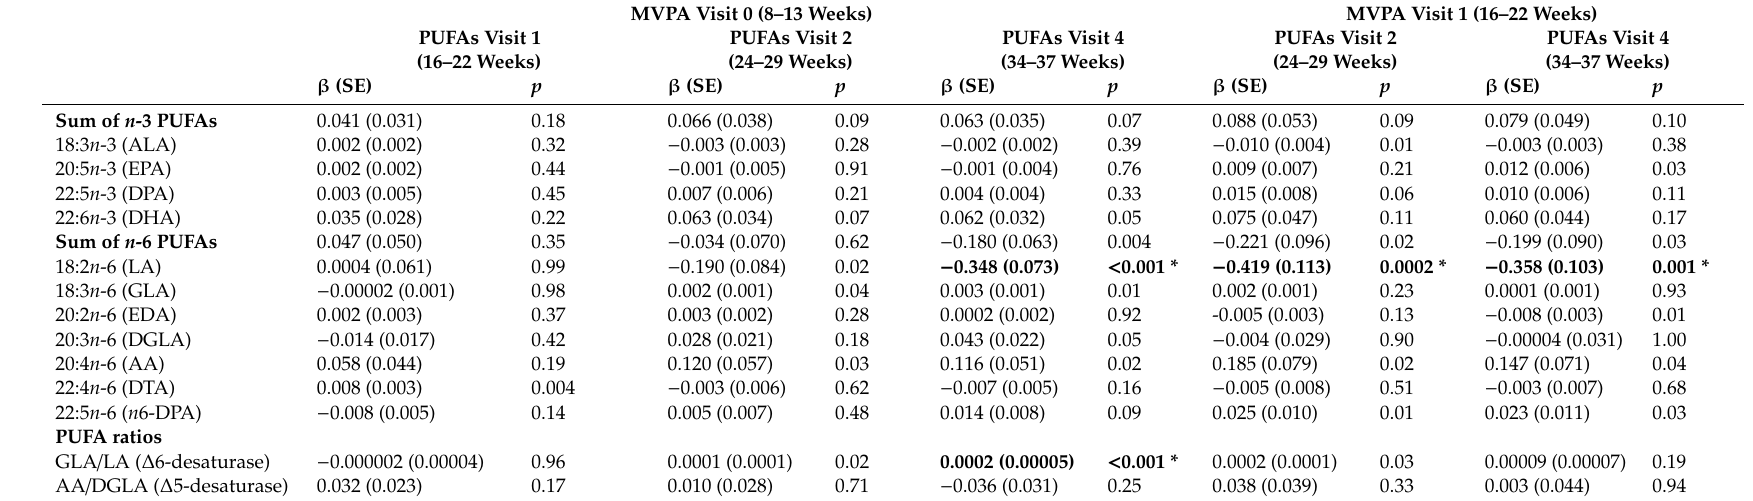
Table 3. Prospective associations of maternal moderate-to-vigorous physical activity (MVPA) and plasma phospholipid polyunsaturated fatty acids (PUFAs) in the NICHD Fetal Growth Studies—Singleton